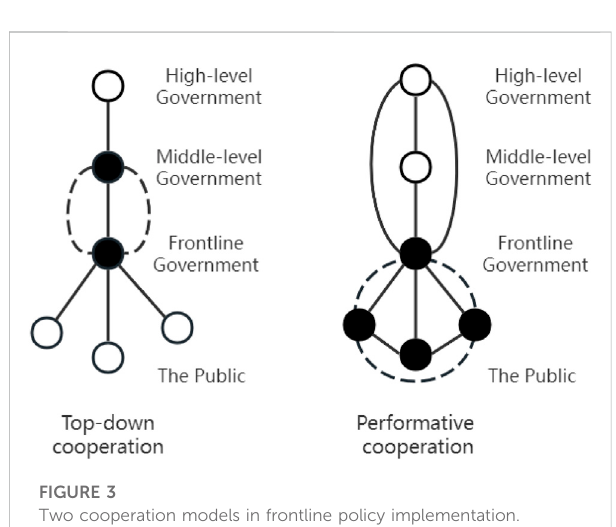
FIGURE 3 Two cooperation models in frontline policy implementation. Note: The black circles are the subjects involved in the cooperation, the white circles are the subjects not involved in the cooperation, and the dotted line is the interactive relationship of the